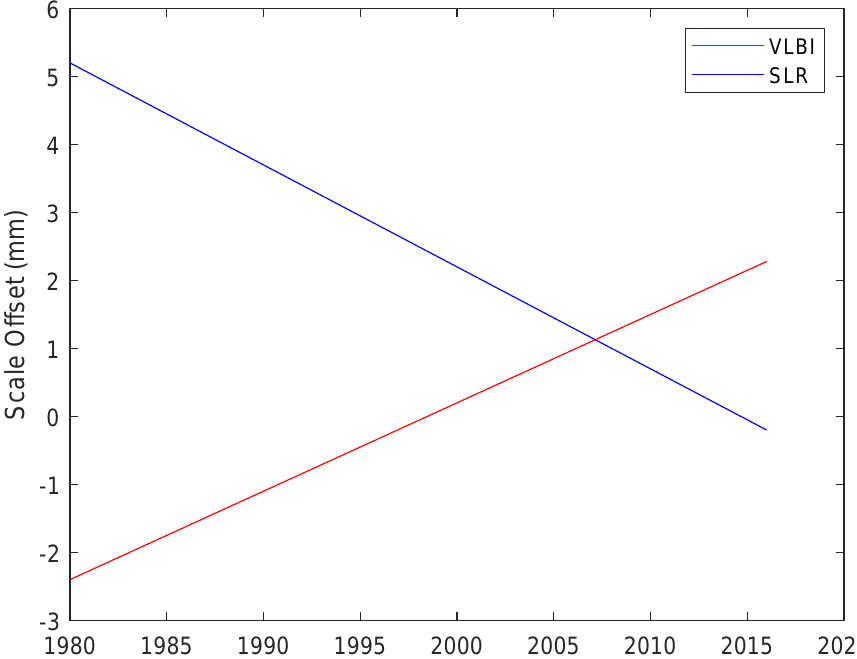
Figure 2. The linear trend between scales of the VLBI (red) and SLR (blue) long-term solutions from DGFI-TUM and